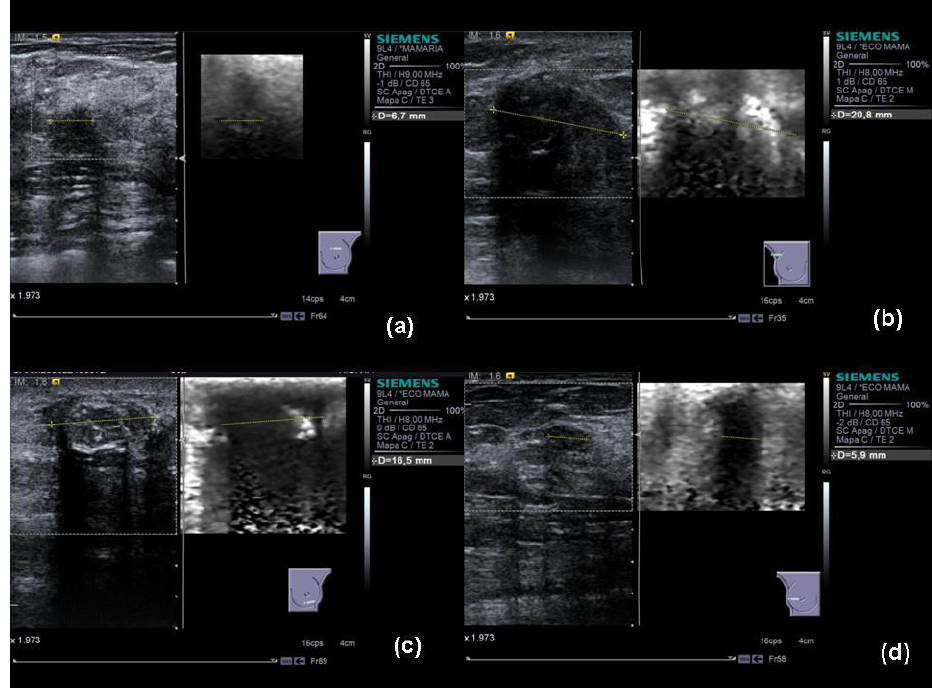
Figure 1. Shear wave elastography patterns. Pattern 1 ( a )—a pattern of nodular elasticity similar to adjacent tissue. Pattern 2 ( b )—a pattern of elasticity that is soft in most of its area. Pattern 3 ( c )—a pattern of elasticity that is stiff in most of its area. Pattern 4 ( d )—a pattern of elasticity that is stiff over the entire nodule without exceeding the limits of the lesion.